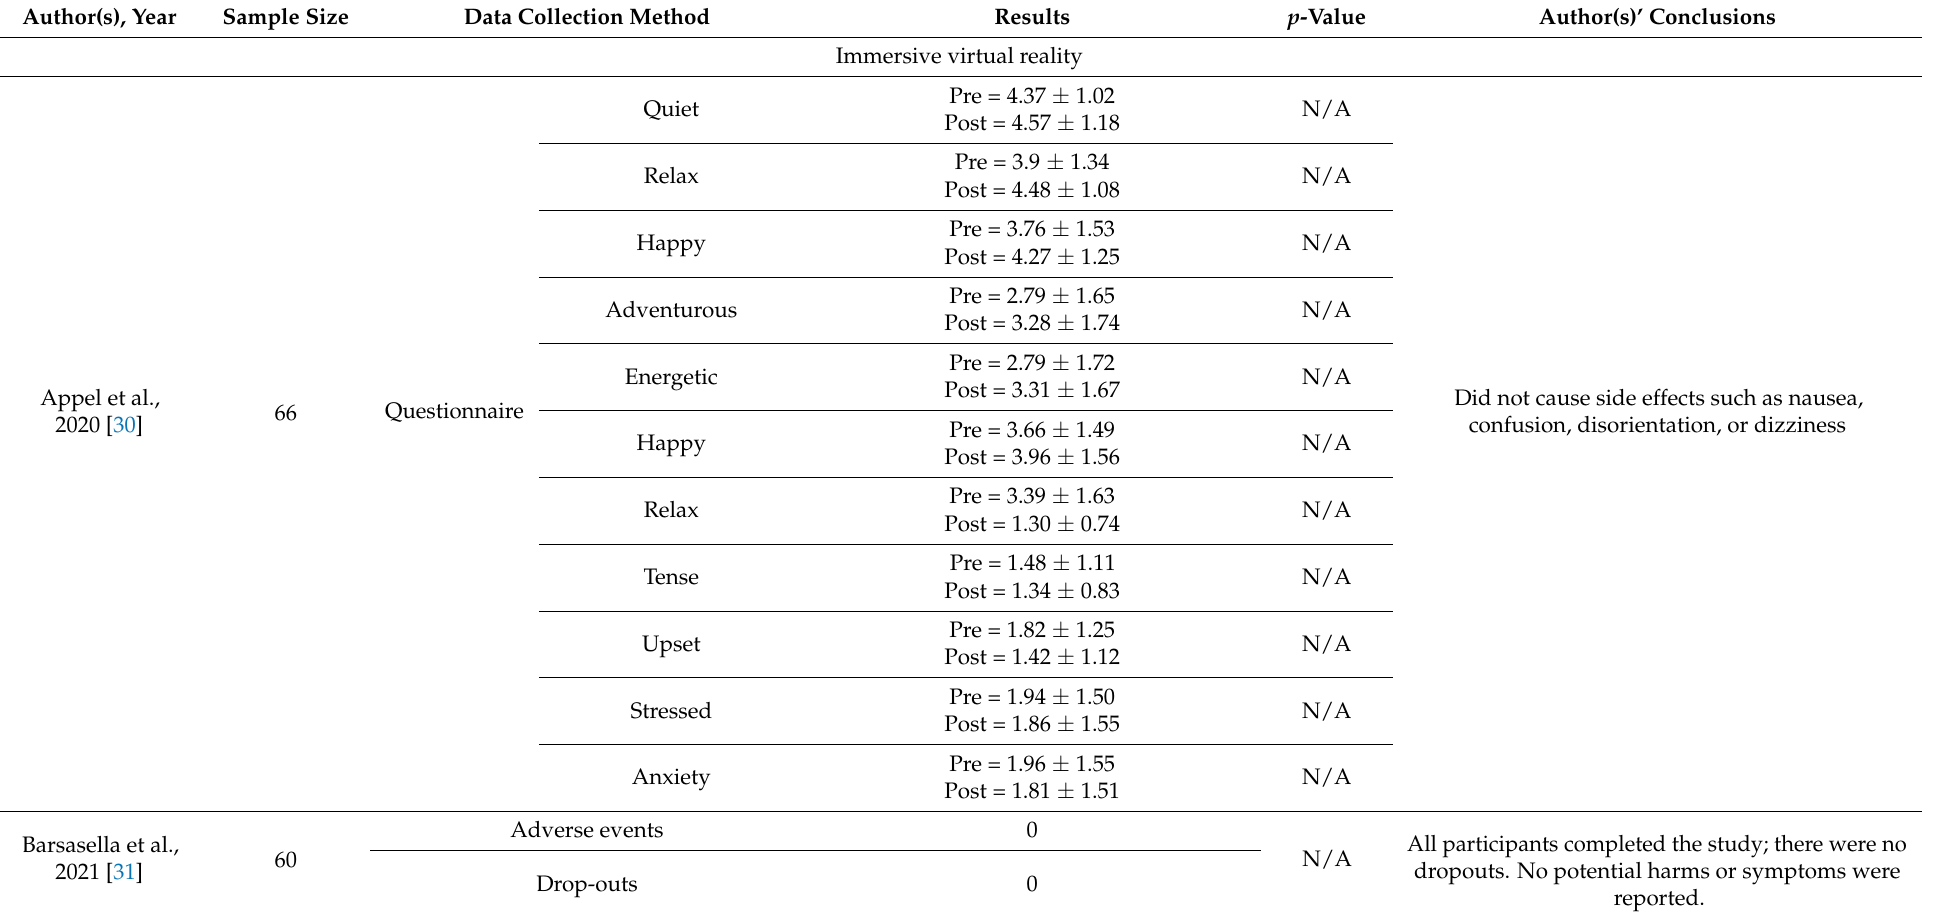
Table 6. Results and author(s)’ conclusions on the feasibility of immersive technologies with a geriatric